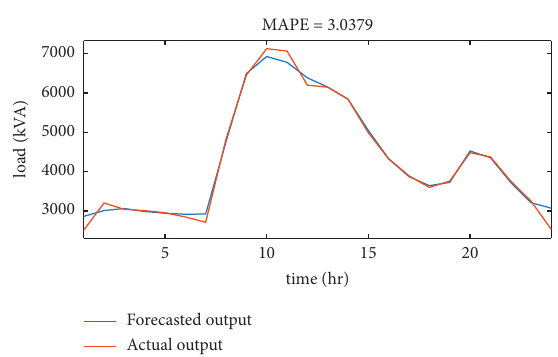
Figure 14: The Fuzzy-PSO prediction of Meskel load.